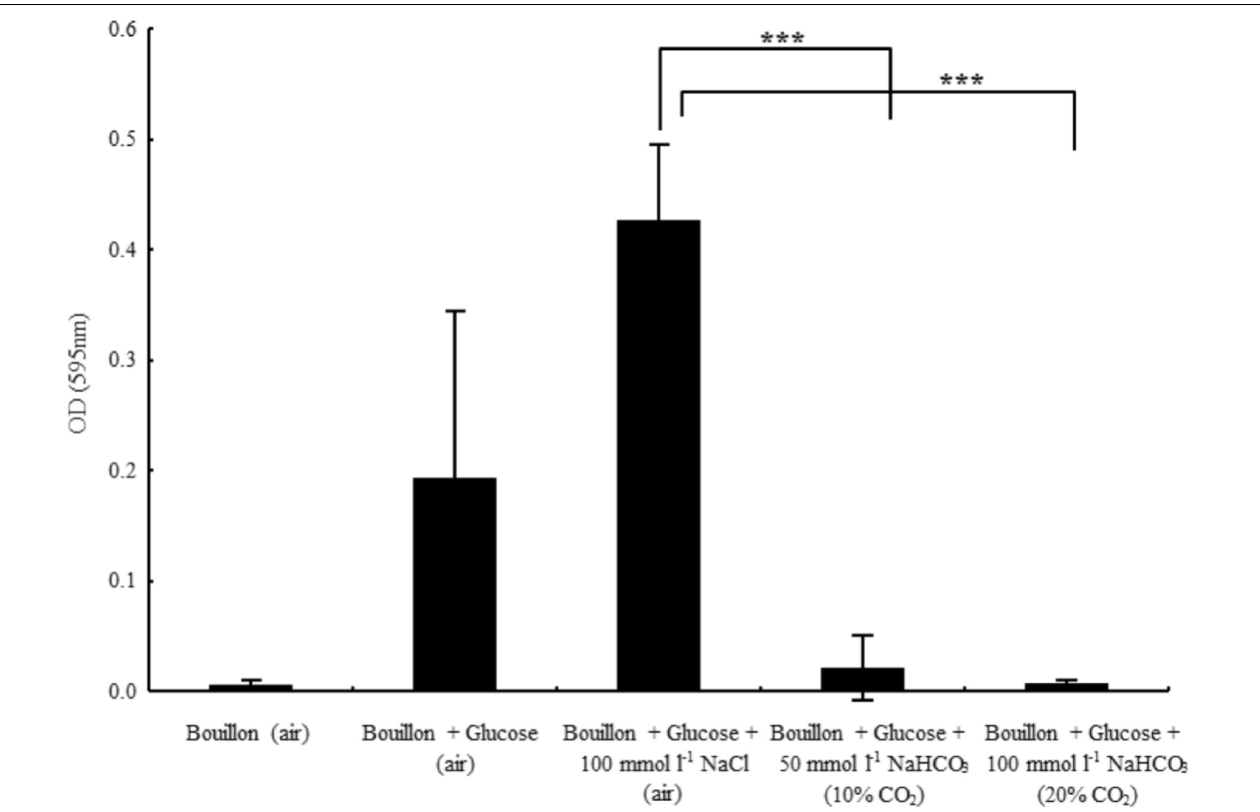
FIGURE 4 | Biofilm formation capacity of Pseudomonas aeruginosa in glucose-containing bouillon (4 g l − 1 ) in the presence of sodium chloride and two different concentrations of sodium bicarbonate. Please note that in the absence of glucose no biofilm formation was observed. ∗∗∗ P <